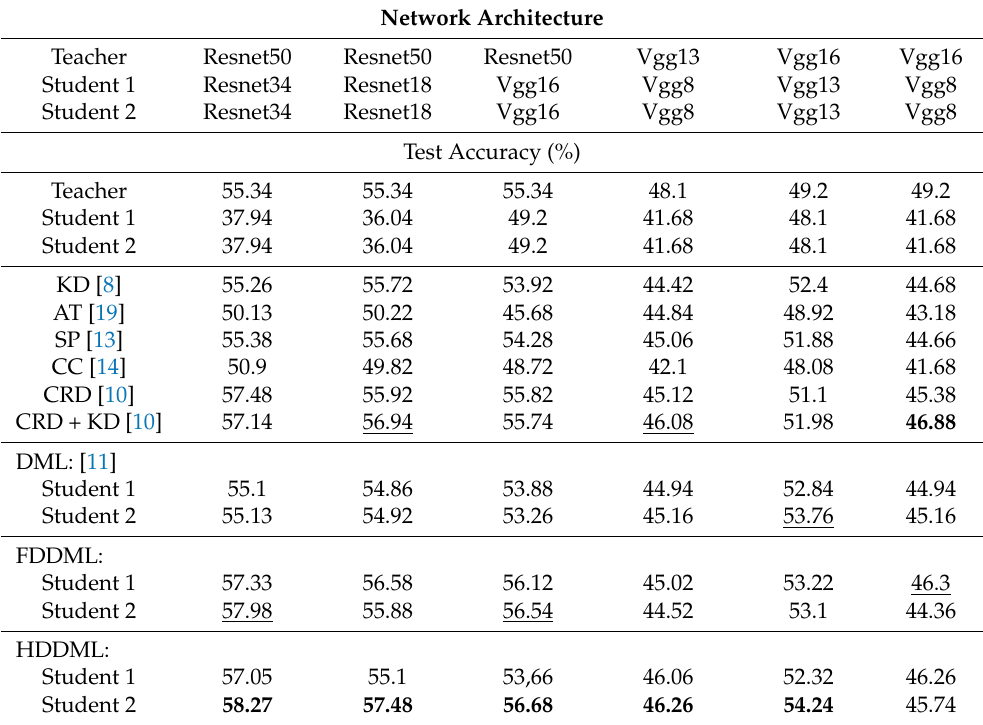
Table 4. Comparing results top-1 accuracy on the TinyImageNet datasets with 64-Image size. Network